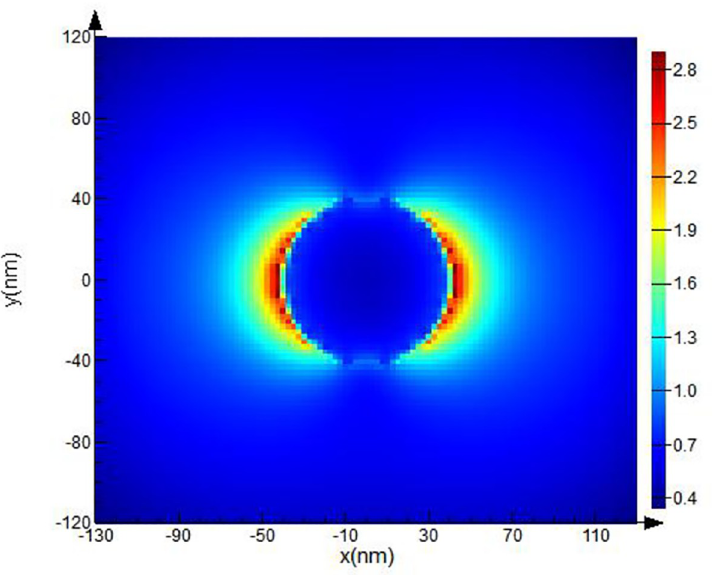
Fig 2. FDTD model of Pt NPs with 40 nm radii for λ = 251 nm excitation